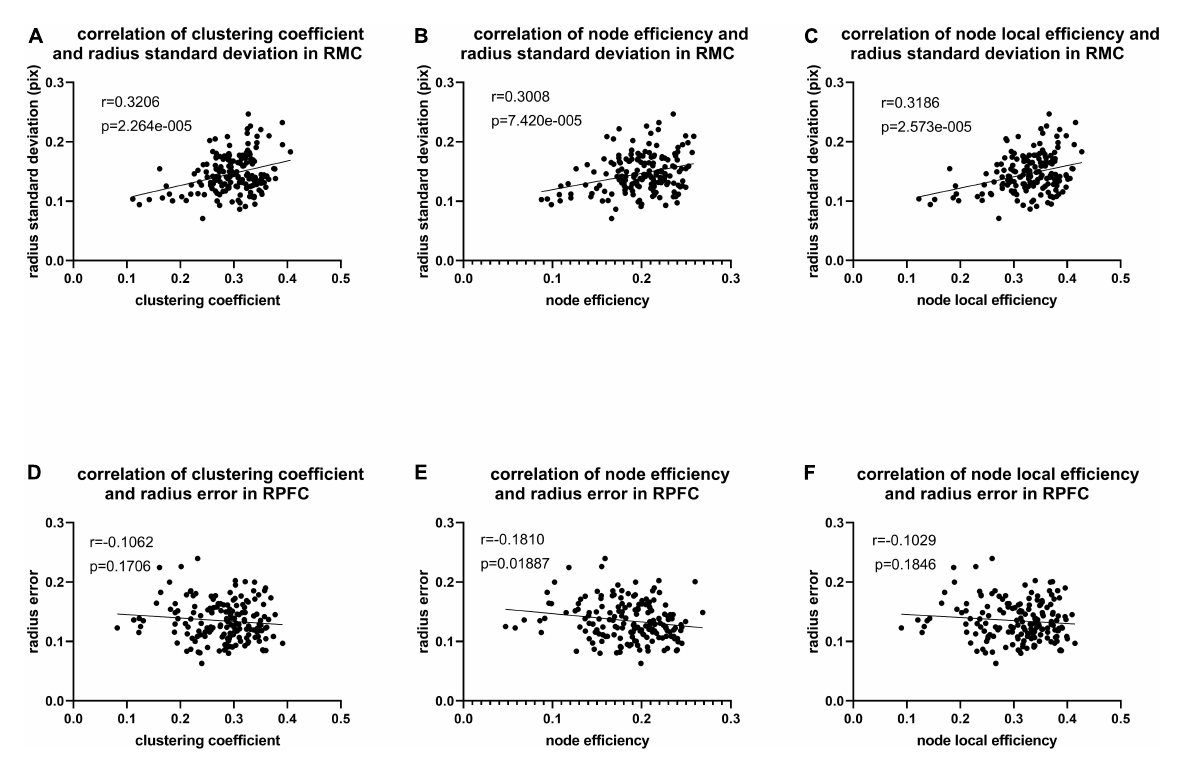
FIGURE9 (A) Correlation of radius standard deviation and clustering coefficient (corr = 0.321, p < 0.001) in RMC. (B) Correlation of radius standard deviation and node efficiency (corr = 0.301, p < 0.001) in RMC. (C) Correlation of radius standard deviation and node local efficiency (corr = 0.319, p < 0.001) in RMC. (D) Correlation of radius error and clustering coefficient (corr = –0.106, p = 0.171) in RPFC. (E) Correlation of radius error and node efficiency (corr = –0.181, p = 0.019) in RPFC. (F) Correlation of radius error and node local efficiency (corr = –0.103, p = 0.185) in